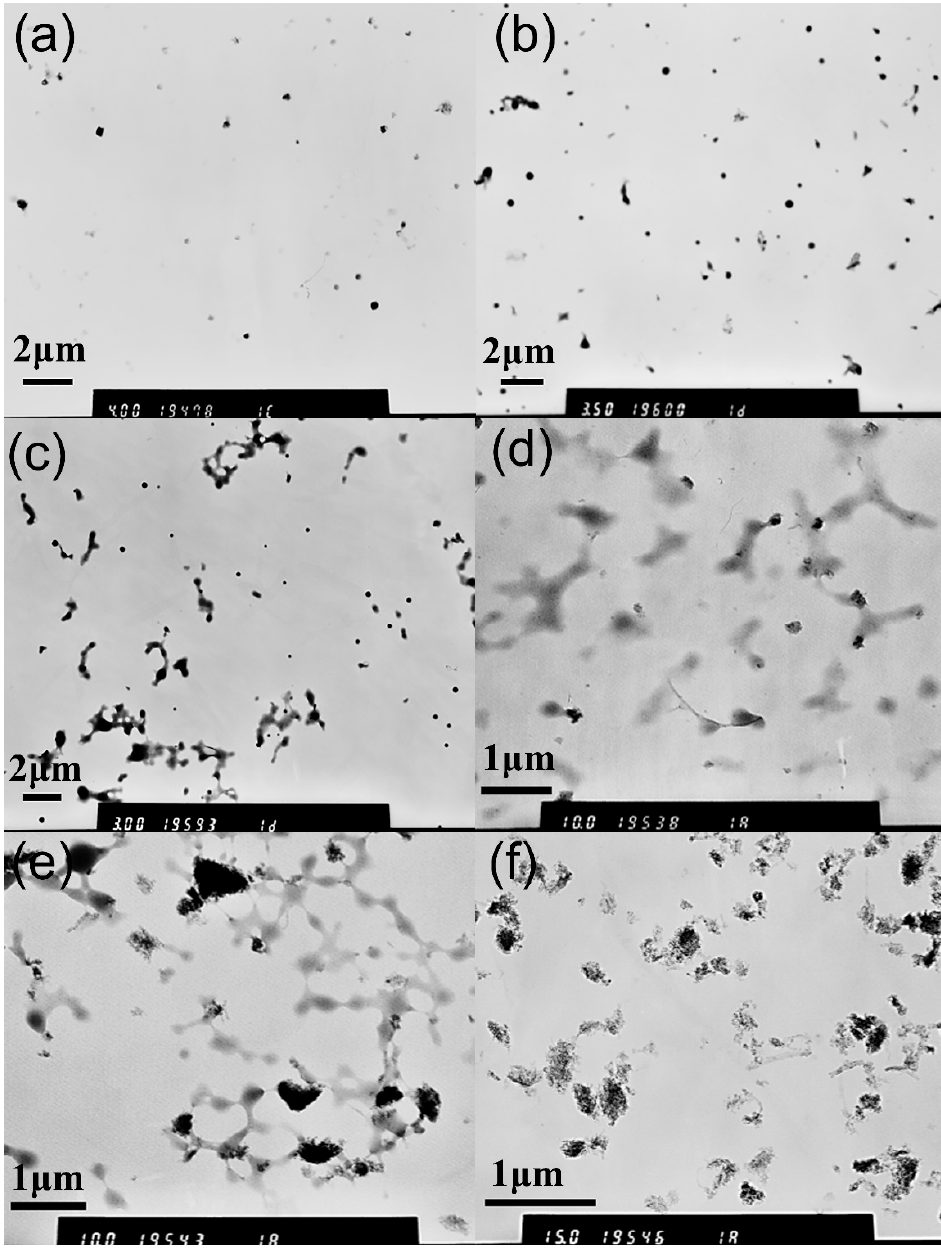
Figure 1. Transmission electron microscopy (TEM) images of drug-loaded methoxy polyethylene glycol-poly (D,L-lactic acid) (MPEG-PDLLA)/carbon nanotube (CNT) nanocomposites obtained at different mass ratios of carboxyl-modified multi-walled carbon nanotubes (c-MWCNTs)/MPEG-PDLLA: ( a ) 0; ( b ) 0.005:1; ( c ) 0.01:1; ( d ) 0.02:1; ( e ) 0.05:1; ( f ) 0.1:1.